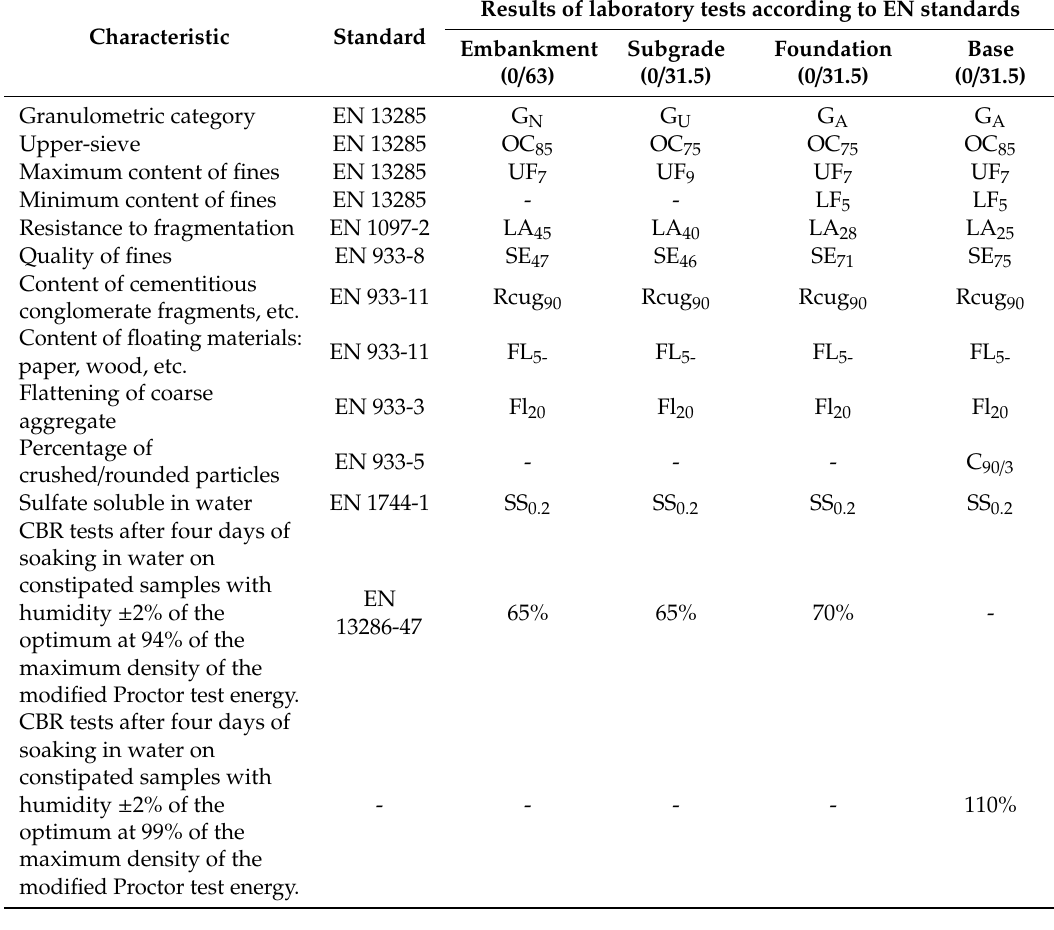
Table 5. Results of the laboratory tests on the designed